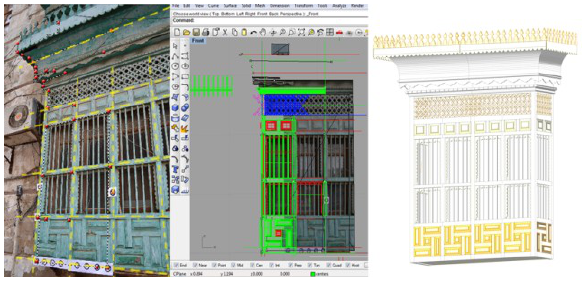
Figure 9. DSM project, table shows maximum residual